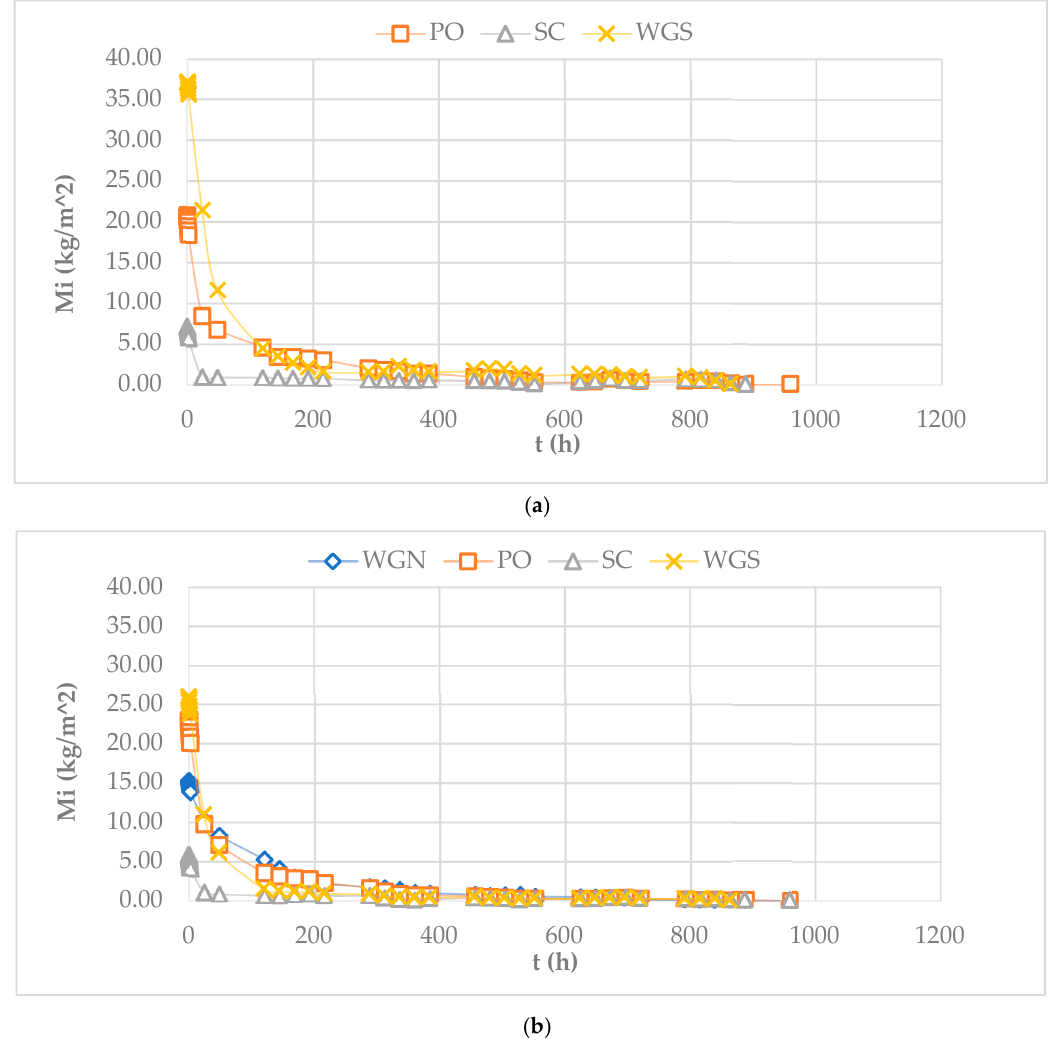
Figure 3. Drying curves of the mortars at ( a ) 180 days and ( b ) 365 days.